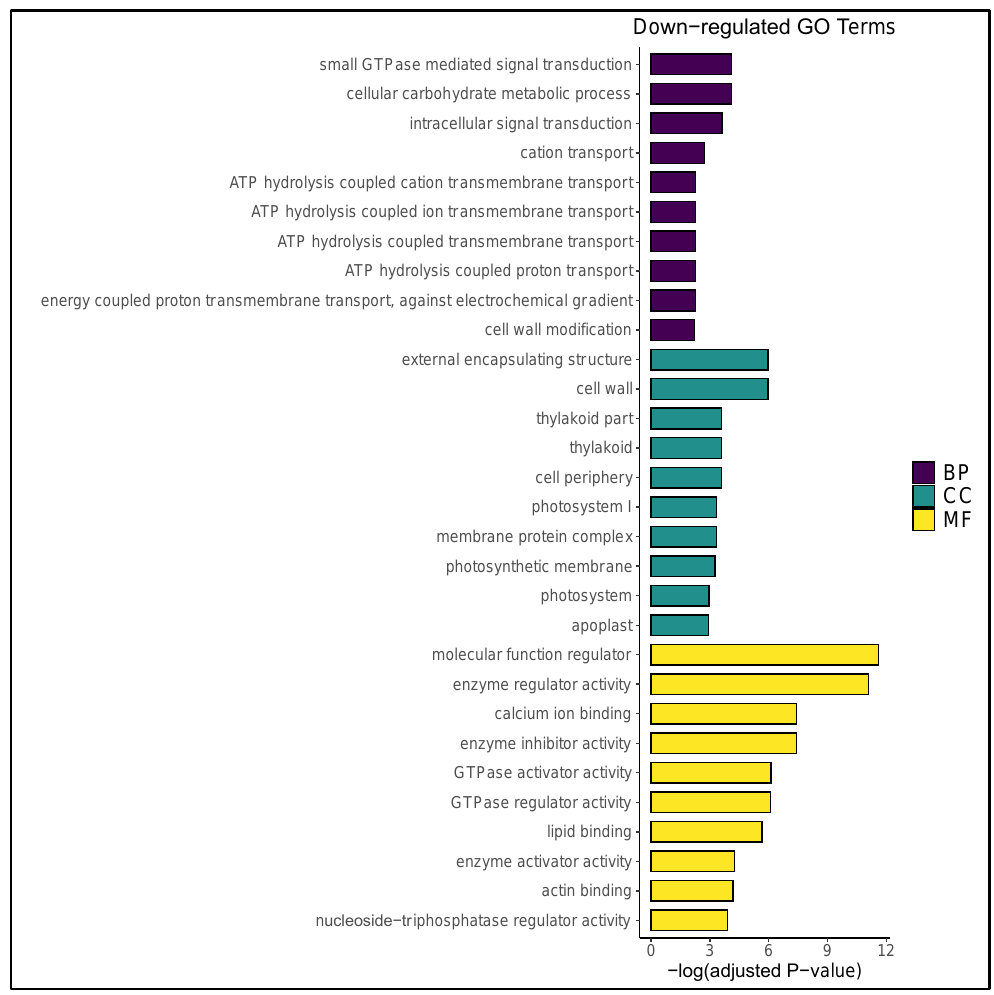
Figure 2. Downregulated gene ontology (GO) terms in the temperature-stressed microspore population with respect to the untreated control. Statistically significant biological processes (BP), cellular components (CC), and molecular functions (MF) are ranked in descending order by adjusted p -value ( − log[adjusted p -value]). A comprehensive list of enriched GO terms is available in Supplementary File 2. It is well-established that microspore totipotency requires decreased biosynthesis of starch and lipid bodies and that excessive starch accumulation inhibits androgenic induction [3,9,52]. Such changes were reflected here by a decrease in overall carbohydrate metabolism, as well as the downregulation of saccharide and lipid metabolic processes (Figures 2 and 3). This is in concert with GO enrichment terminology reported by Seifert et al. [1], as well as the aforementioned decrease in ATP hydrolysis-based transport, the latter of which may obstruct the reaction coupling potential required for starch / glycogen biosynthesis. Additionally, vacuolar-type H + -ATPase activity was suppressed in the stressed microspore population (Supplementary File 2), indicating decreased transport of osmotically active substances and inhibition of endomembrane acidification. This bears significance in the present context due to the reliance of pollen on vacuole-localized sucrose for starch anabolism (Figure 3; Supplementary File 2; [51]). These transcriptional changes likely precede the fragmented vacuole phenotype reported across numerous microspore embryogenesis platforms (Figure 1d;